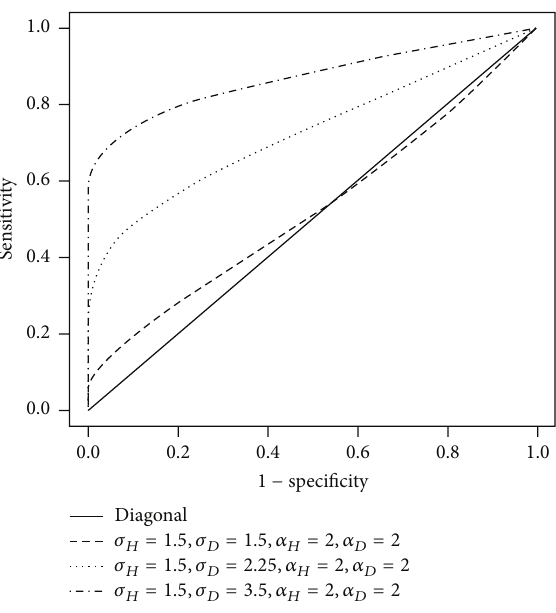
Figure 1: Plot of ROC curves with various combinations of scale and shape parameters of both normal and abnormal populations.